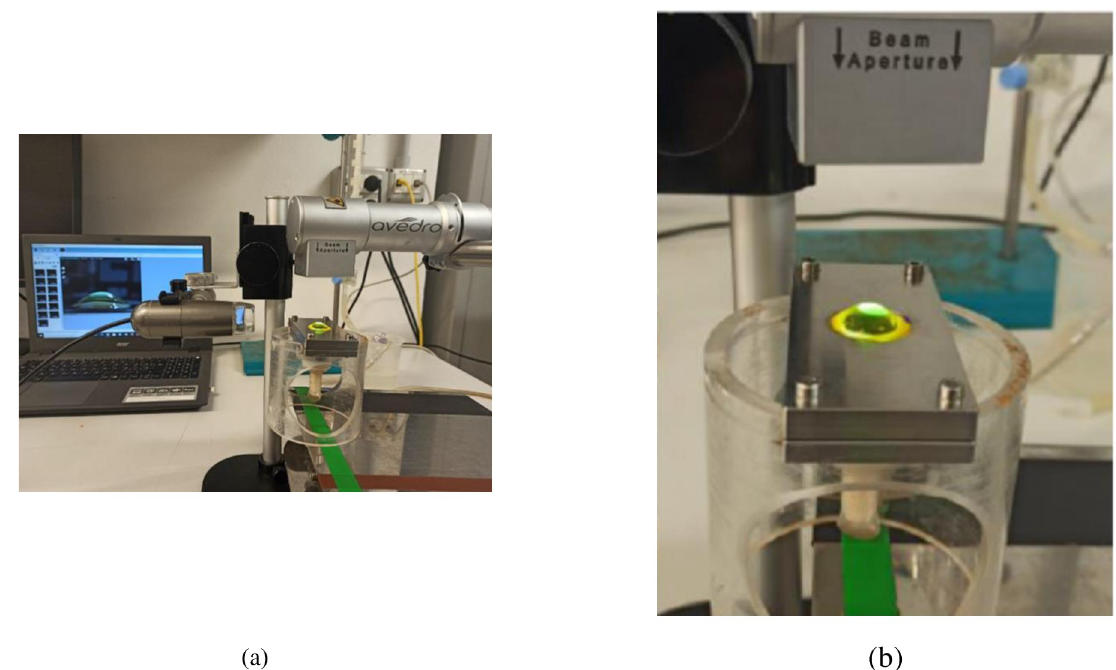
Fig 2. (a) Experimental setup. From left to right: personal computer for image acquisition, Pro Lite Dino Camera; clamping system where the cornea sample is mounted; water column; piping system; constant emission UV-A lamp. (b) AVEDRO lamp used for the UV-A activation of